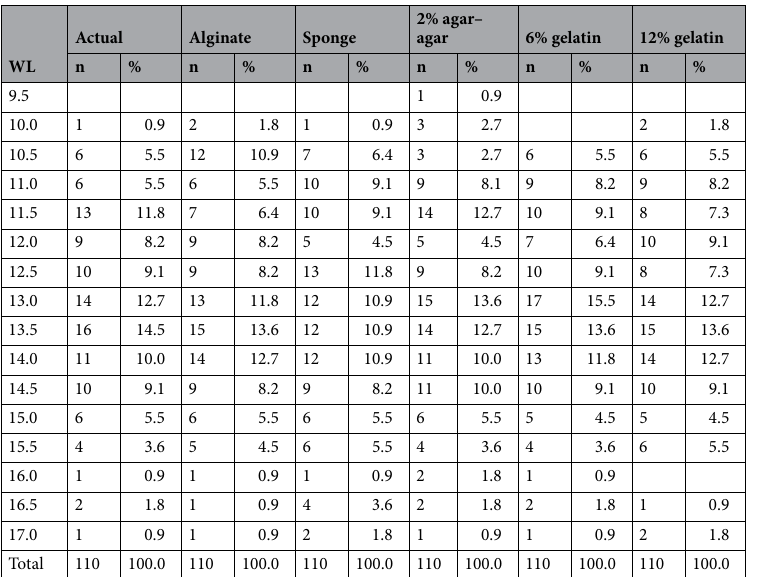
Table 1. Actual working length and different embedding media working lengths determination (mm) distributed according to the corresponding root canal working lengths measured (WL). Significant higher differences between the results obtained with alginate and the actual working lengths are noticeable. However, it should be taken into consideration that the clinically acceptable tolerance of ± 0.5 mm accepted in this investigation, is not being taken into account in this table (n = 110 per research group).